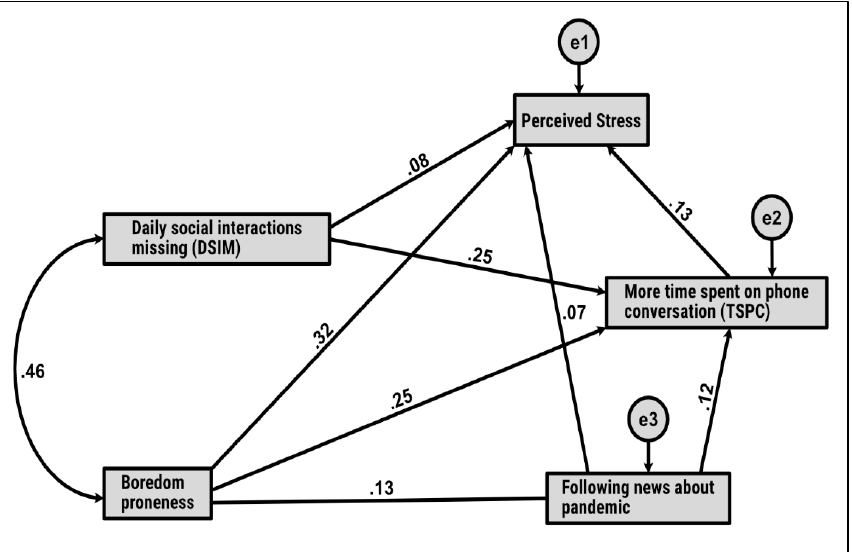
Figure 1. Mediation model: The impact of DSIM and boredom proneness on perceived stress, more TSPC, following the news about the pandemic, and perceived stress; e1, e2, e3-residual variables. All direct and indirect effects of DSIM and boredom proneness on university students’ perceived stress were computed (Figure 1). Three criteria recommended by Schumacker and Lomax (2004) [81] were applied to verify the statistical significance of the proposed model: 1) non-statistically significant chi-square test; 2) the statistical sig- nificance of each parameter estimates; 3) the extent and direction of the parameter esti-